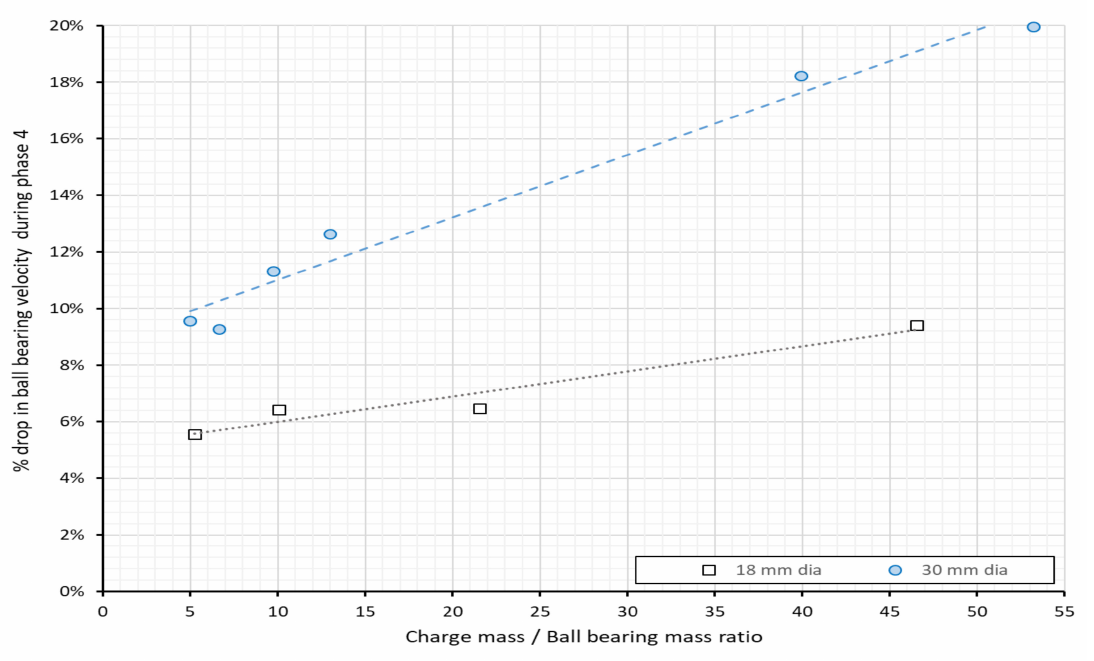
Figure 13. Graph of percentage decrease in ball bearing velocity during phase 4 versus charge mass/ball bearing mass